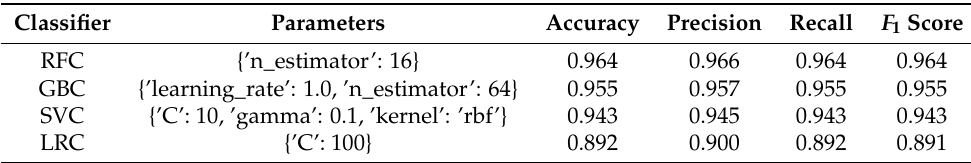
Table 8. Performance scores of the depression classifier using both activity tracking and minimal K-SGDS assessment features on the training set.